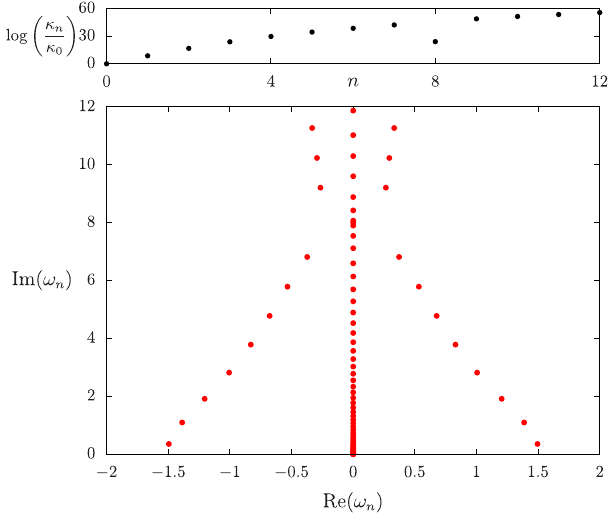
FIG. 12. Schwarzschild QNM problem. Bottom panel: QNMs for the l ¼ 2 axial and polar gravitational modes of Schwarzs- child spacetime, corresponding, respectively, to the (isospectral) Regge-Wheeler and Zerilli potentials (eigenvalues along the imaginary upper half line are the numerical counterpart of the Schwarzschild branch cut, but also the algebraically special QNM ω ; see Ref. [75] for a discussion of this). Note the normali- n ¼ 8 zation 4 M ω , consistent with λ ¼ 4 M after Eq. (68). Top panel: n condition numbers κ normalized to the condition number κ 0 of n the fundamental QNM. Note the relative enhanced stability of the algebraically special